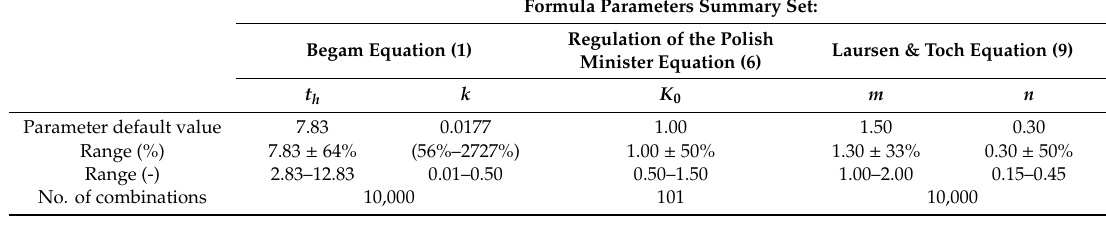
Table 7. Monte Carlo sampling assumptions summary table.